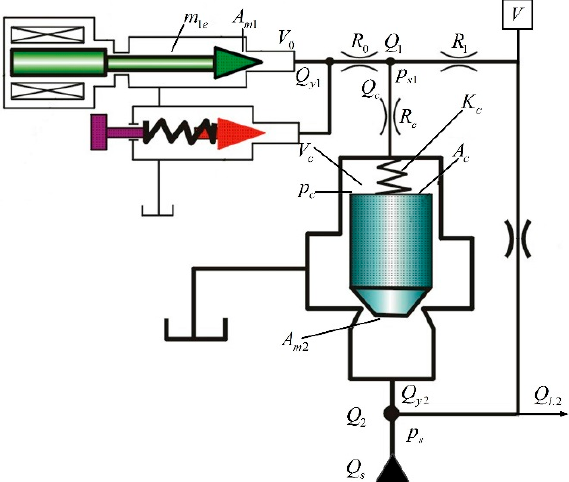
Figure 4. Working principle diagram.